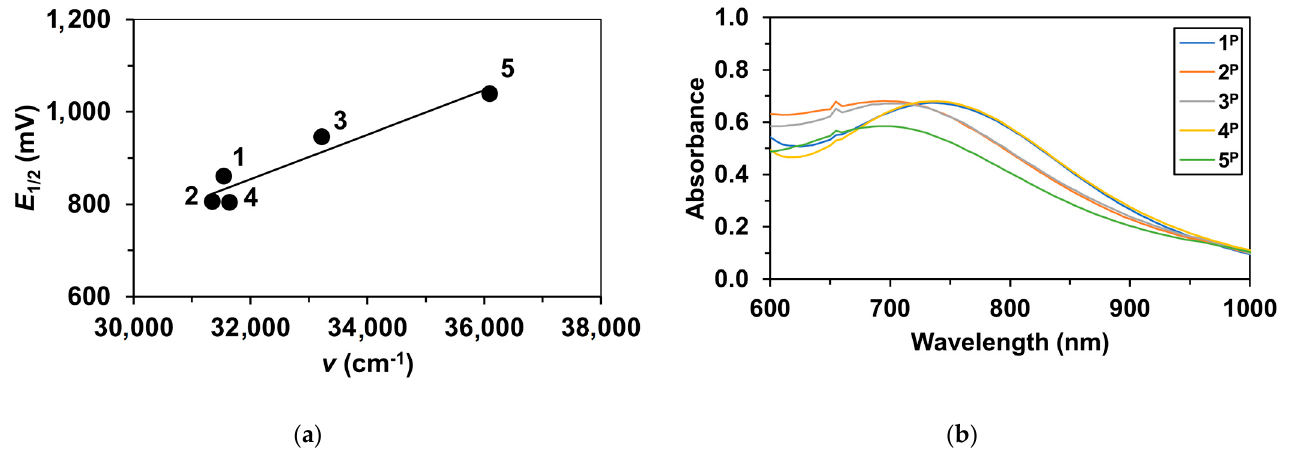
Figure 2. ( a ) Correlation between the redox potential ( E 1/2 ) and the metal-to-ligand charge transfer (MLCT) bands of [Fe II (L 1 -L 5 )] 3 ](CF 3 SO 3 ) 2 ( 1 – 5 ) complexes. ( b ) Characteristic UV–Vis spectra of [Fe III 2 ( µ -O 2 )(L 1 − 5 ) 4 (Solv) 2 ] 3+ ( 1 P – 5 P ) complexes generated by excess of H 2 O 2 : [ 1 – 5 ] 0 = 0.5 × 10 − 3 M, T = 298 K, l = 1 cm, V = 2 mL MeCN.